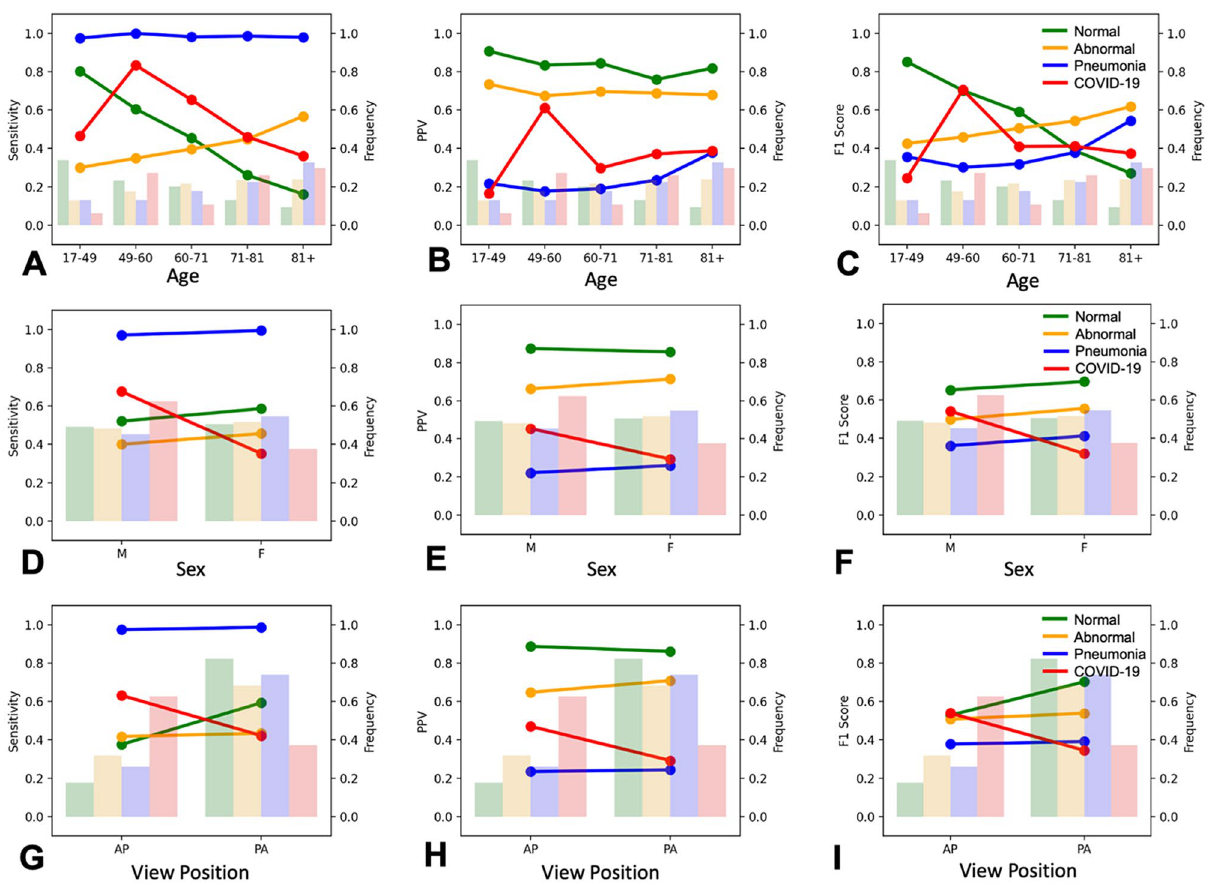
Figure 5. Effect of patient age, sex, and view position on CovIx performance. Model performance, expressed as sensitivity, positive predictive value (PPV), and F1 Score is represented as lines, whilst class frequencies, expressed as proportion of total images in the testing set, are shown as